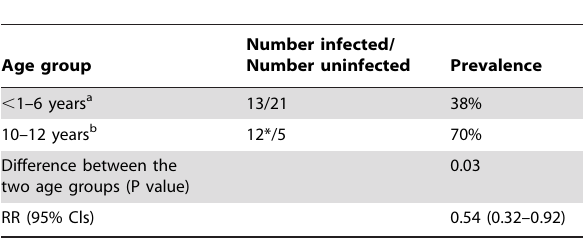
Table 2. Hydatid prevalence in sheep/goats by age in Datangma district, Ganzi